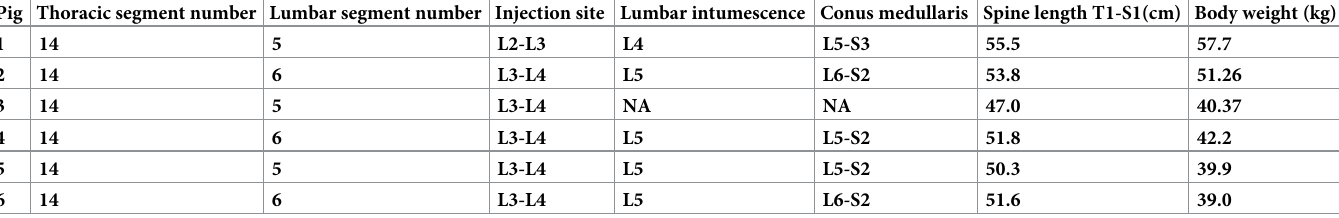
Table 2. Spinal formula, body weight, spinal length, injection site, and location of the lumbar intumescence and conus medullaris of the thoracolumbar spine in 6 Yucatan sows.